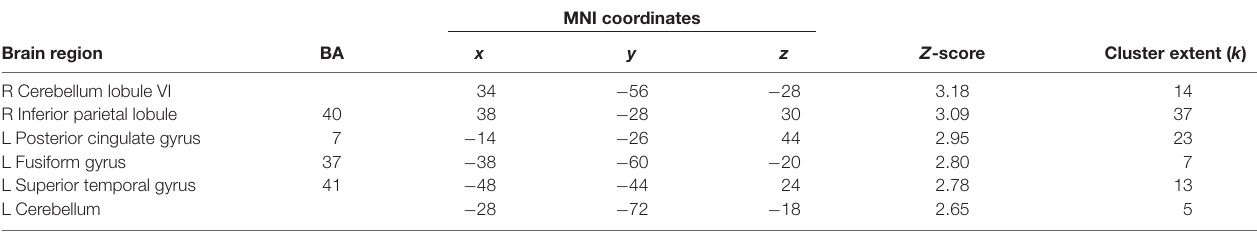
MNI coordinates